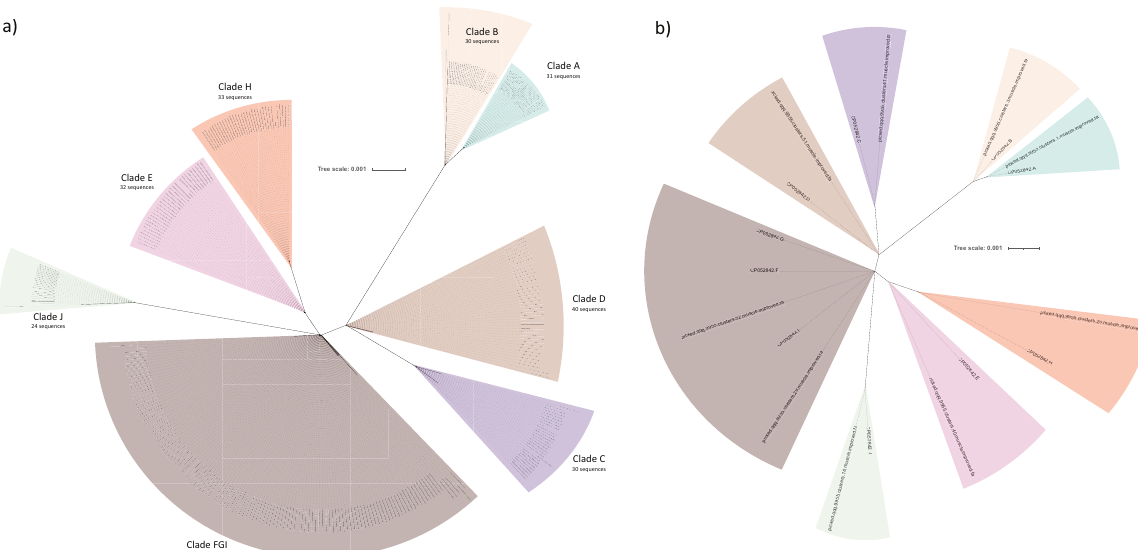
Fig. 4 Phylogenetic analysis of the Bacillus subtilis RoC-ITS sequences. The tree scale shows the number of edits per base per unit length. a Phylogenetic tree of Bacillus RoC-ITS sequences along with the 10 reference Bacillus subtilus str 168 rrns (labeled CP052842.A-J with the letters corresponding to their order in ascending base pair coordinates on the reference genome). The RoC-ITS reads are found in eight distinct clades in accordance with the reference rrns. The single largest clade containing three reference rrns (F, G, and I) and consists of the two identical rrns plus a third rrn that differs by only two deleted bases. b A phylogenetic tree of the reference rrns and the consensus sequences derived from the nine clusters produced after clustering the Bacillus RoC-ITS sequences at 99.55% genera in the arti fi cial community ( Inquilinus , Rhodococcus , and Mycobacterium ) were all intentionally excluded by this process and did not have suf fi cient read counts to provide for a robust analysis.